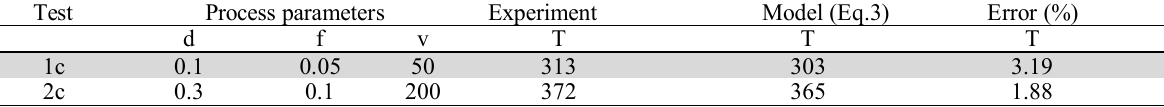
Comparison of results obtained from experiment with model